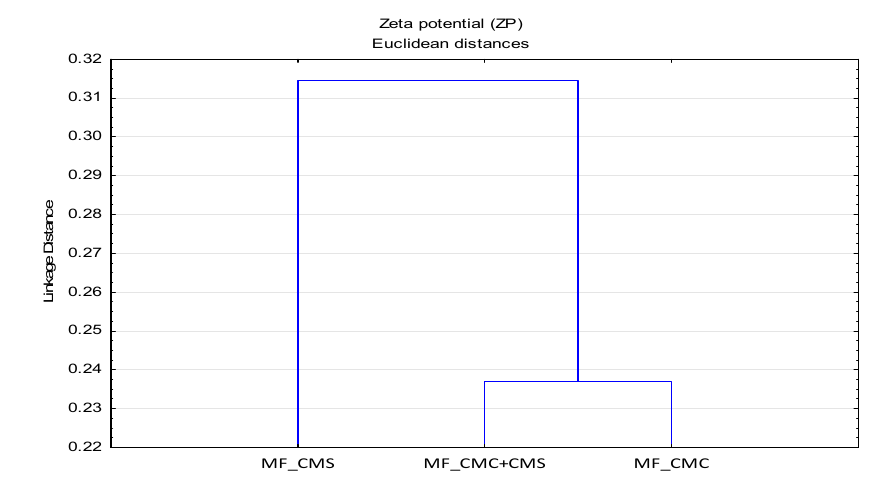
Figure 7. Dendrogram of zeta potential data of MF as a function of impact of surface modifiers (SMs). To understand the interaction of SMs in the determination of incineration residue (IR) and zeta potential (ZP), a cluster analysis was performed for all experimental IR and ZP data at pH 9, which represents the pH of the detergent solution. The results of the analysis are presented by dendrograms (Figure 8), which show a grouping of samples where CMC dominates up to the amount of the linkage distance of 1. After that, two separate groups were formed with samples subjected to the impact of CMS.